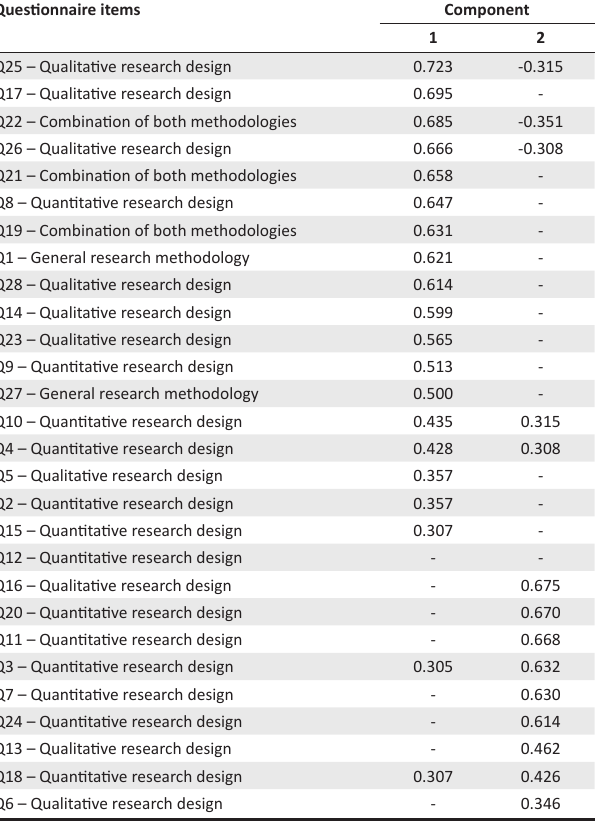
TABLE 3: Forced two-factor component matrix. Questionnaire